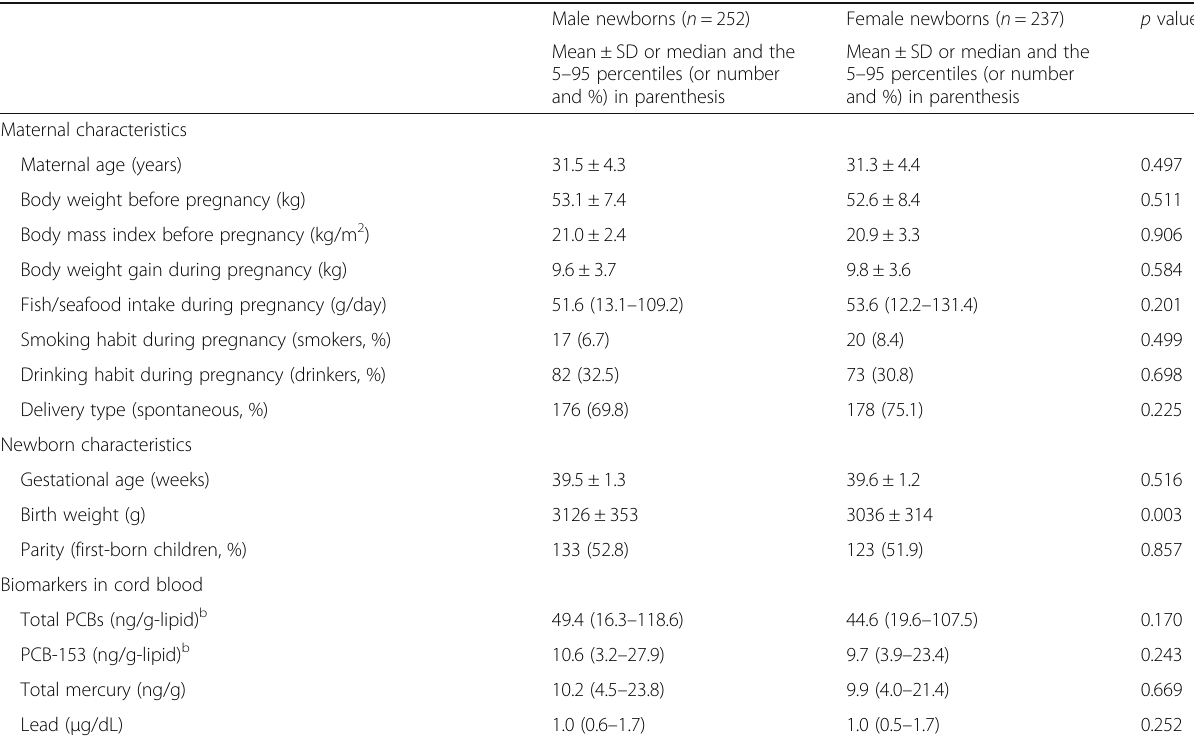
Table 1 Basal characteristics and exposure levels in 489 mother-baby